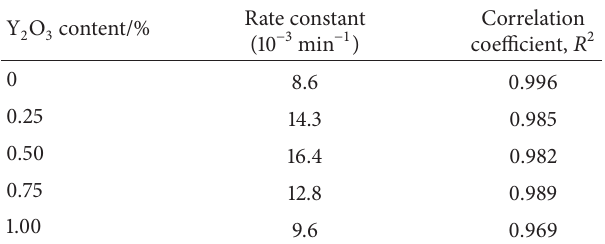
Table 4: Degradation rate as a function of the concentration of O and pseudo-first order rate constants derived from fitting Y 2 3 experimental data to computer model. Y O content/% 2 3